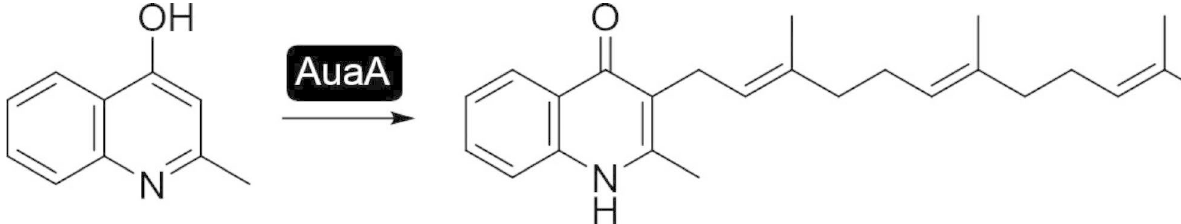
Fig. 1 Biosynthetic conversion of 4-hydroxy-2-methyl-quinoline (HMQ) into aurachin D by the membrane-bound farnesyltransferase